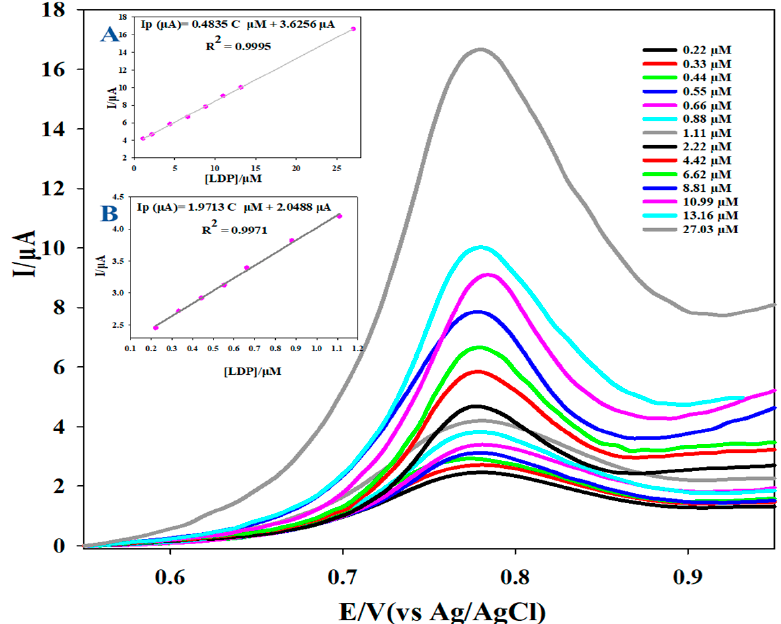
Figure 7. SWVs of several dilutions of MTX (27.03–0.22 μ M) in pH 7.0 BRB using the g-CN/CPE sensor at a scan rate of 0.1 V s − 1 . The inset demonstrates the plot of the peak current as a function of concentrations in the range of ( A ) 0.22 × 10 − 6 to 1.109 × 10 − 6 and ( B ) 1.109 × 10–6 to 27.03 × 10 − 6 M.